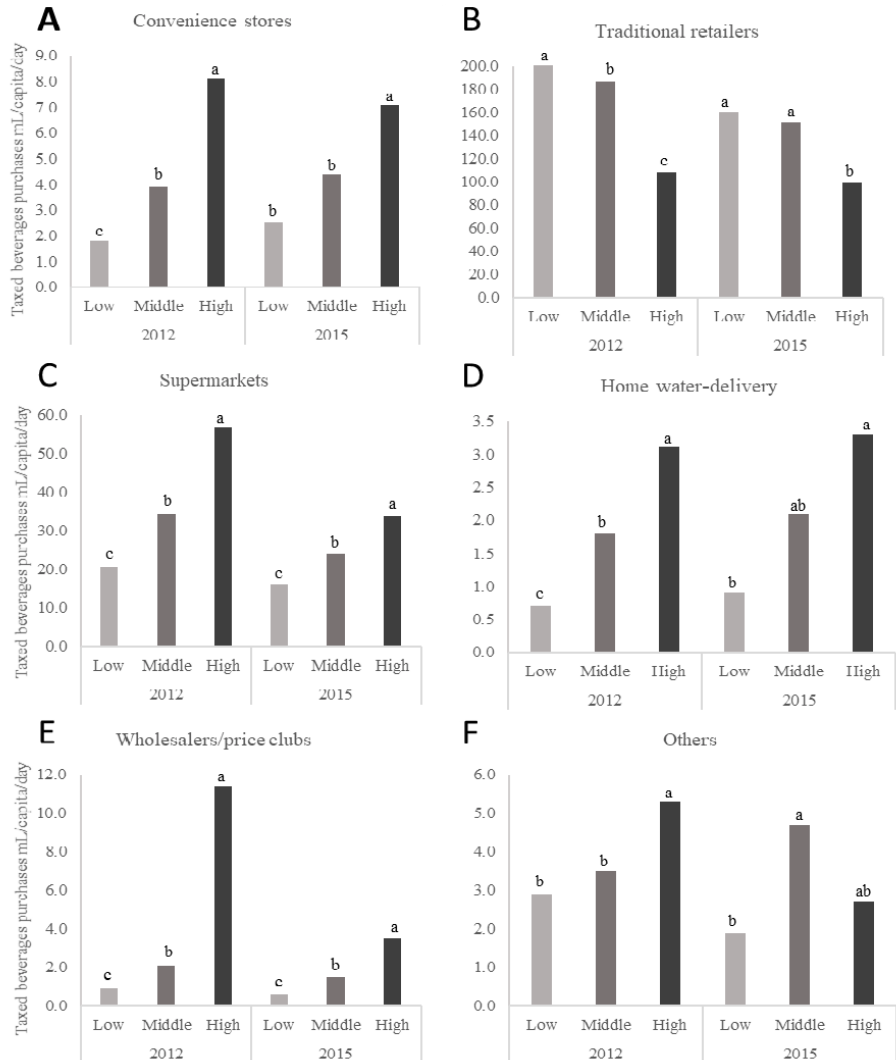
Figure 1. Daily per capita purchases of taxed beverages in urban Mexican households, according to socioeconomic status (SES), for the years 2012 and 2015. n = 959 in the low-SES, n = 3133 in the medium-SES, and n = 1721 in the high-SES group in 2012 and n = 1170 in the low-SES, n = 2690 in the medium-SES, and n = 1633 in the high-SES group in 2015. Subgraphs refer to taxed beverage purchases by store-type including ( A ) convenience stores, ( B ) traditional retailers, ( C ) supermarkets, ( D ) home water-delivery, ( E ) wholesalers and price clubs, and ( F ) Other sources. Values represent weighted unadjusted means. SES classification is based on the socioeconomic index provided by Nielsen. Multivariate linear regression models were used to predict per capita daily purchases of taxed beverages according to store-type, SES, and year of purchases. Data presented are restricted to the Nielsen Company’s Mexico Consumer Panel Services purchasing information for 2012 and 2015 only for clarity. However, p -values represent the p -trend for years 2012, 2013, 2014, and 2015. Labeled means with a different letter represent significant differences between the SES categories means ( p -trend < 0.05) where the letters a,b,c are used to differentiate the highest, middle, and lowest mean values for each figure in the panel. Source: Authors’ own analyses and calculations based on data from Nielsen through its Mexico Consumer Panel Service for the food and beverage categories for January 2012 to December 2015. The Nielsen Company, 2016. Nielsen is not responsible for and had no role in preparing the results reported